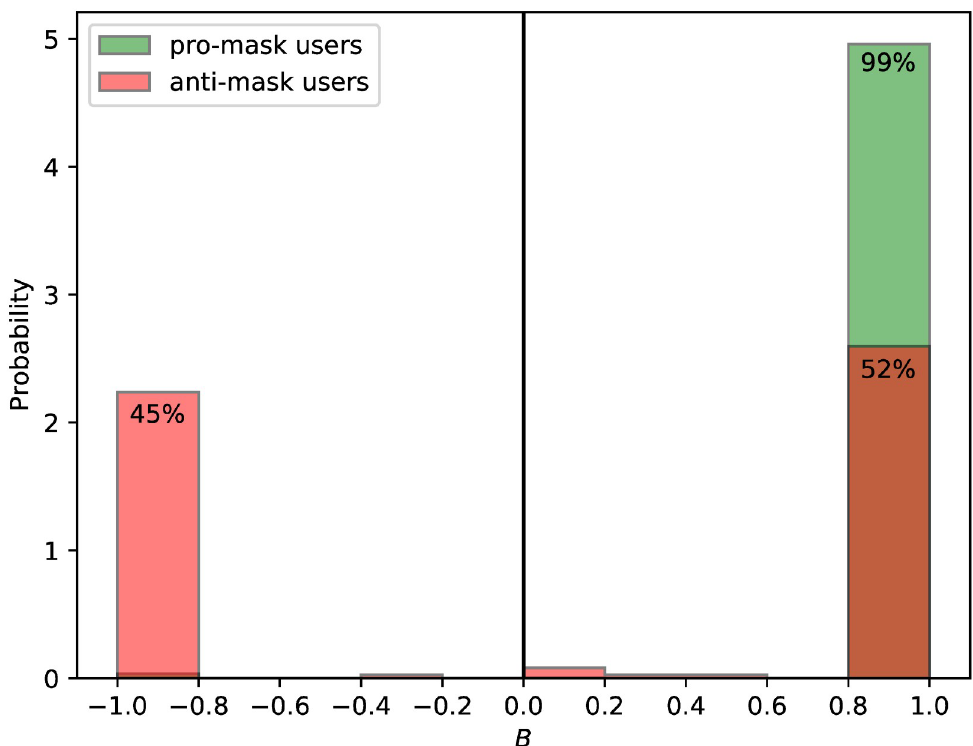
Fig 6. The distribution of the response bias B (Eq 4) for both pro-mask and anti-mask users. The vast majority of users fall near the extremes of possible values of the response bias (i.e. within 0.2 of B = +1 or B = − 1), with the percent of users in a given group indicated for each extreme